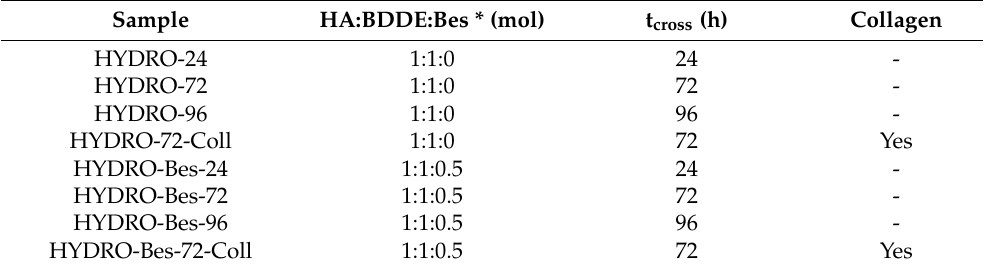
Table 2. Hydrogel name, reactant molar ratio, and crosslinking time (t cross